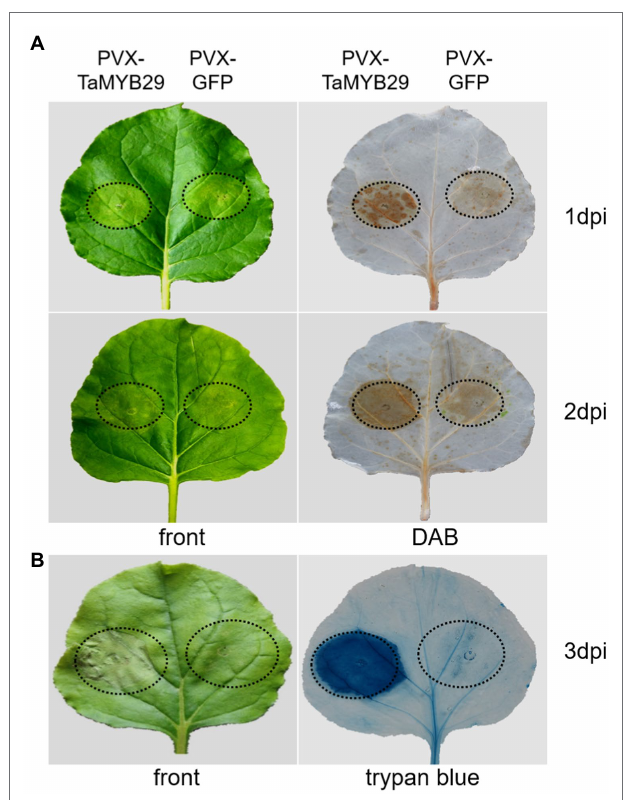
FIGURE 6 | Expression of TaMYB29 -induced ROS accumulation and pathogen-independent cell death in N. benthamiana leaves. (A) Symptoms of N. benthamiana leaf areas expressing TaMYB29 or GFP gene from 1 to 2 days post-infiltration (dpi). The left and right panels represent the front and after DAB staining, respectively. (B) Symptoms of N. benthamiana leaf areas expressing TaMYB29 or GFP gene at 3 dpi. The left and right panels represent the front and after trypan blue staining, respectively. These experiments were repeated at least three times and got the same